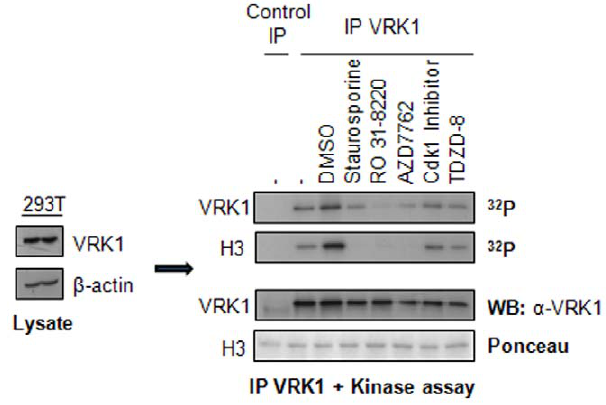
Figure 2. Inhibition of human VRK1 expressed in 293T cells. The endogenous VRK1 protein, from HEK 293T cells, was immunoprecipitated and used for an in vitro kinase assay. The relative inhibition was determined at a concentration of 75 m M for those inhibitors previously identified by testing them in bacterially expressed VRK1. Endogenous VRK1proteinwas immunoprecipitatedwith1F6mAb,anti-VRK1, ascontrol an anti-HA mAb was used. The VRK1 immunoprecipitate was incubated in the presence of 75 m M inhibitor, 5 m M ATP and 5 m Ci of [ c 32